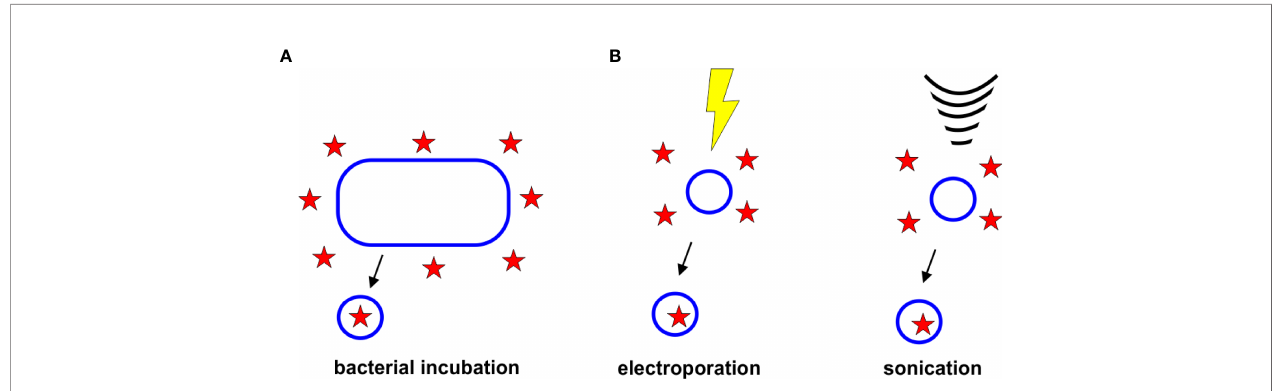
FIGURE 4 | Strategies for Drug Loading. (A) Bacterial Incubation. Bacteria grown in the presence of antibiotics have been found to release antibiotic-containing OMVs. (B) Electroporation and Sonication. Electroporation and sonication can enhance drug loading within the OMV